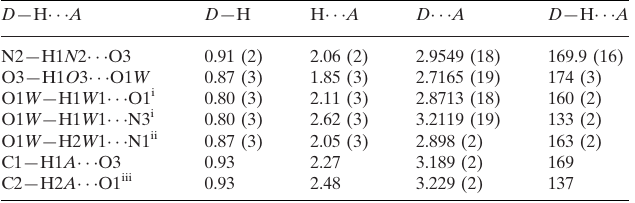
24474 measured reflections 6515 independent reflections 4012 reflections with I > 2 (cid:2) ( I ) R int = 0.069 H atoms treated by a mixture of independent and constrained refinement (cid:2) (cid:6) max = 0.37 e A˚ (cid:4) 3